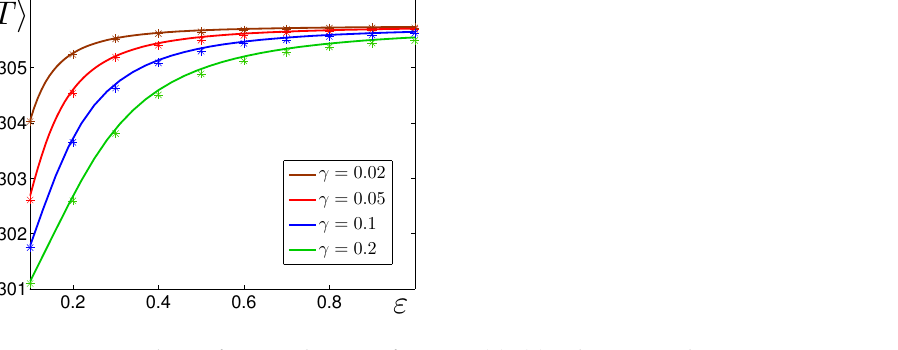
Figure 7. Mean values of T -coordinates of system (2), (3) solutions with σ 1 = 0, σ 2 = 1 versus ε . = ¯ m are plotted by solid lines, and results of direct numerical T Results of analytical estimations (cid:104) (cid:105) T simulations are shown by asterisks. (cid:104) (cid:105)